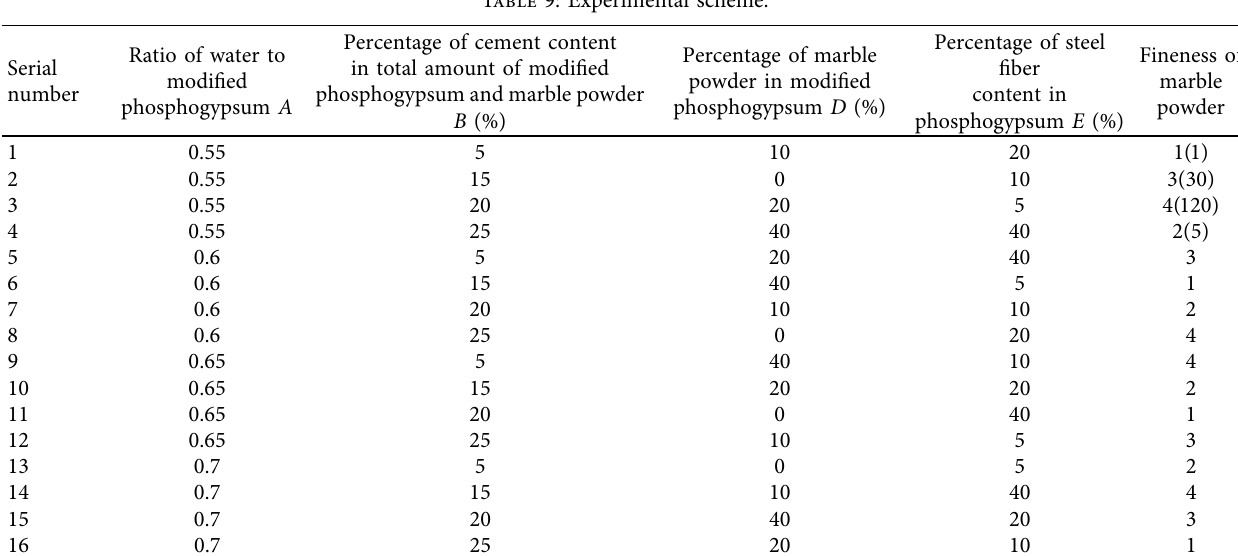
Table 9: Experimental scheme.